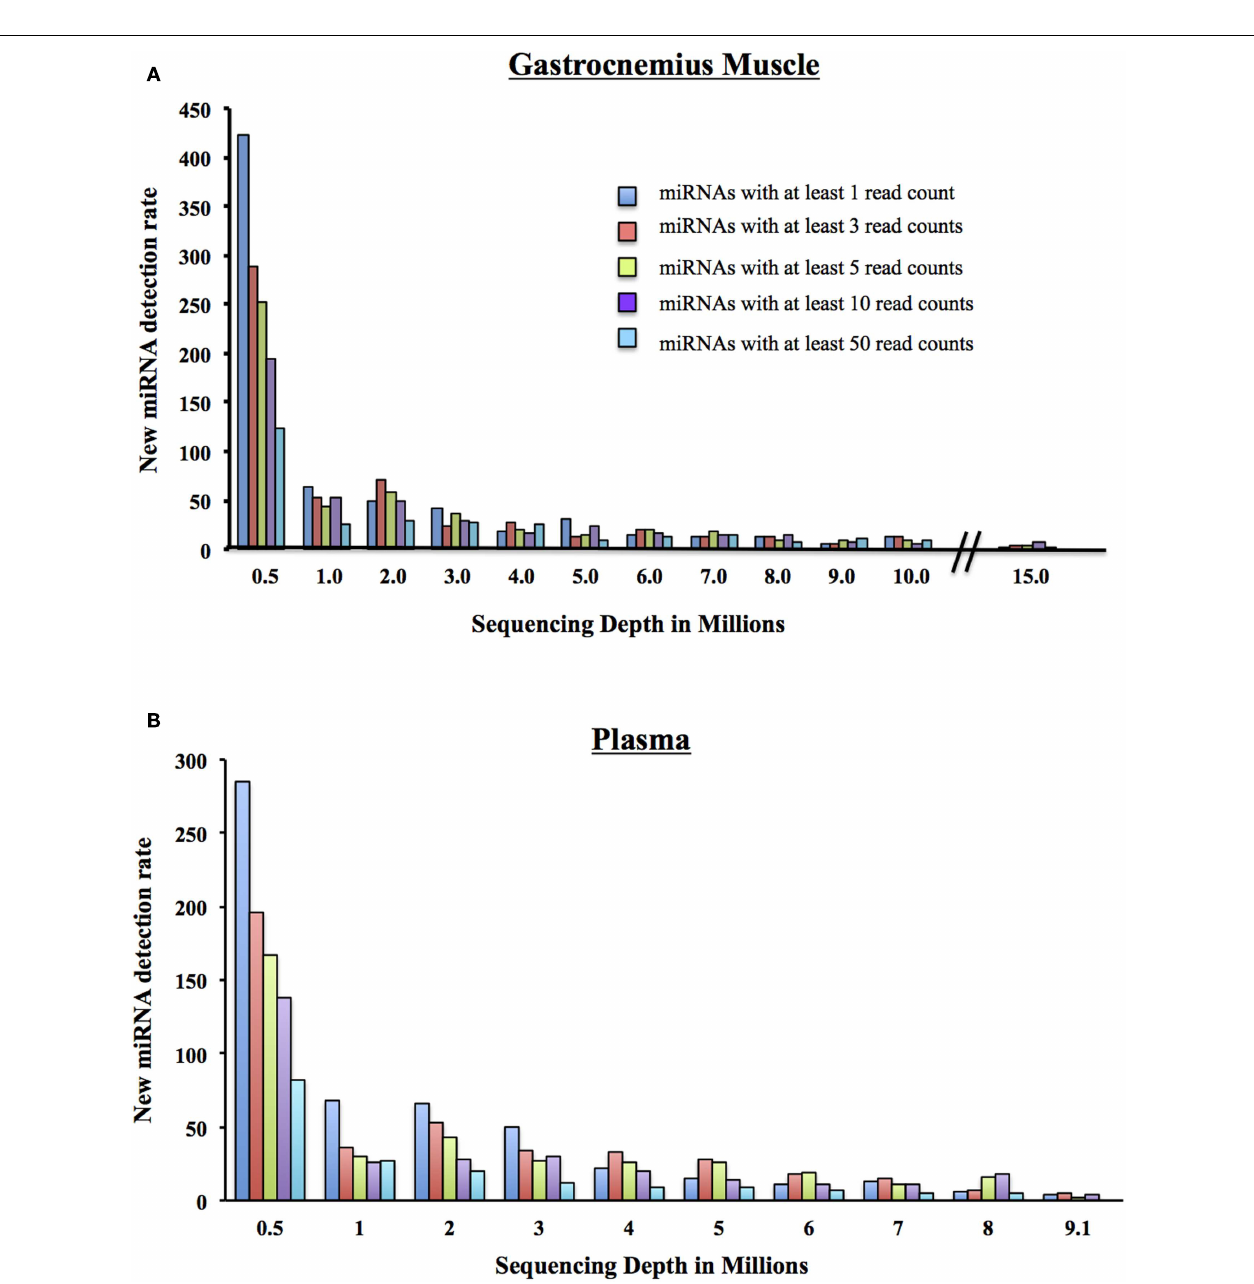
FIGURE 5 | New miRNA detection rate. (A) As a million reads at a time are added to the sequencing depth of the Gastrocnemius Muscle, the number of newly detectable miRNAs is reduced. Displayed are the number of newly detected miRNAs with at least 1, 3, 5, 10, or 50 reads.